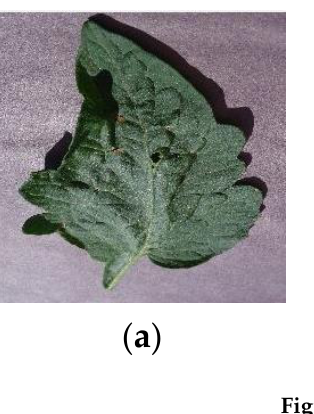
Figure 7. Ten segmented leaf images including nine leaf disease images and one healthy image: ( a ) Bacterial spot disease; ( b ) Early blight disease; ( c ) Late blight disease; ( d ) Leaf mold disease; ( e ) Septoria leaf spot disease; ( f ) Two-spotted spider mites; ( g ) Target spot disease; ( h ) Yellow leaf curl virus dis-ease; ( i ) Mosaic virus disease; ( j ) Healthy leaf.